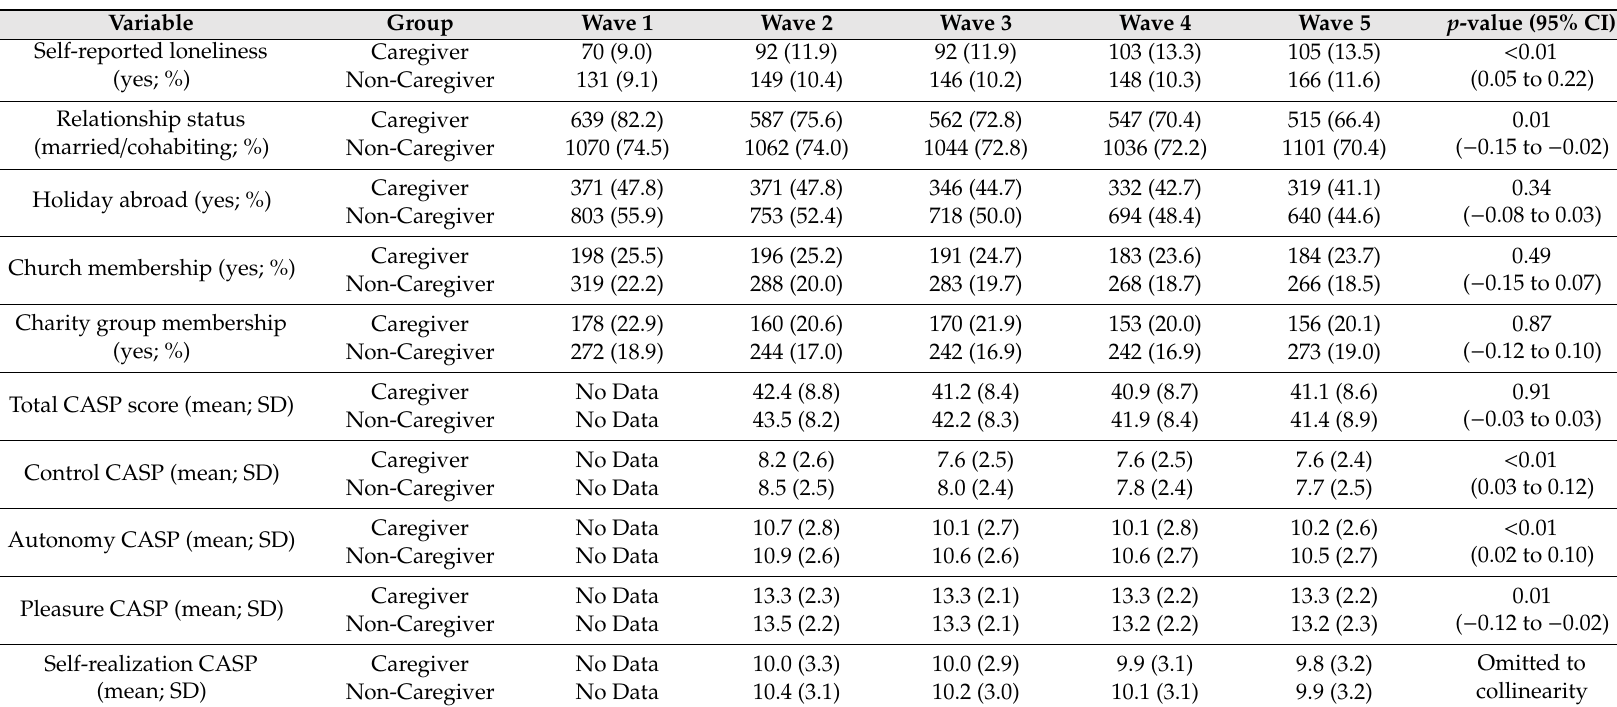
Table 3. Summary of the trajectories of psychosocial variables for caregivers and non-caregivers across five English Longitudinal Study of Ageing (ELSA) Waves (10 years; caregivers: 777 vs. 1463